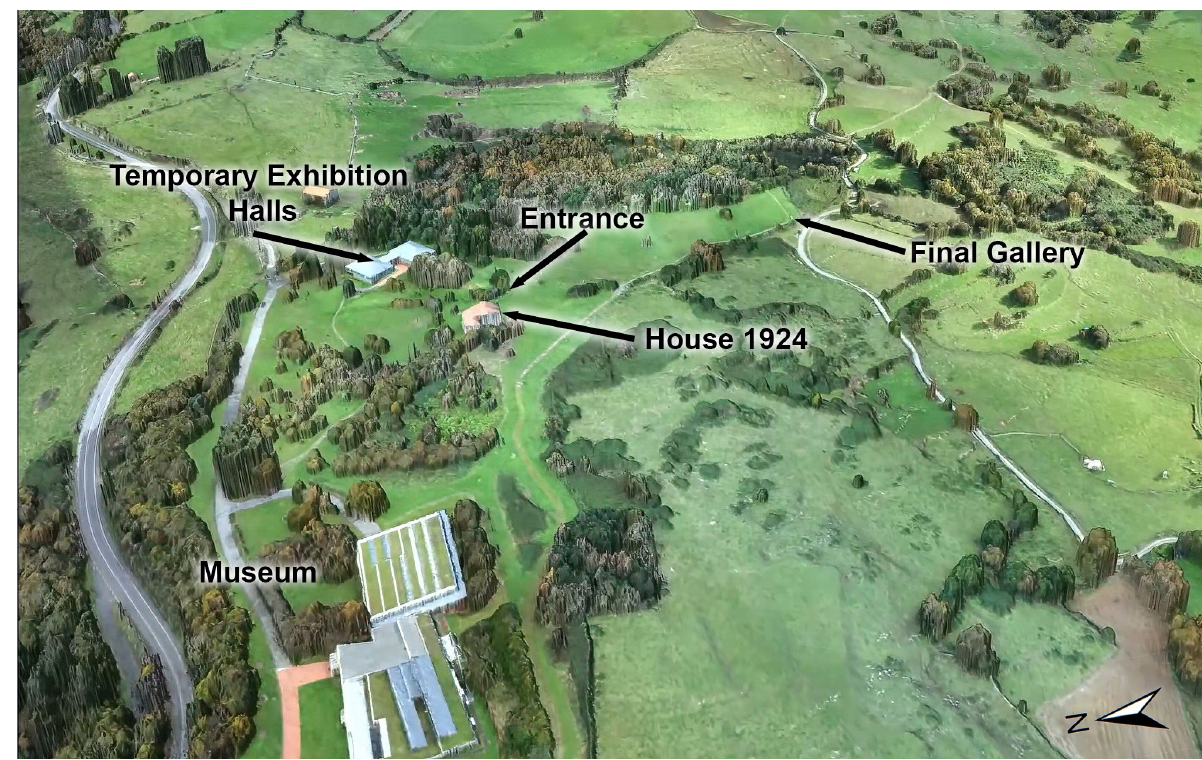
Figure 4. View of the 3D model derived from UAV photogrammetric flight of the surroundings of Altamira Cave.